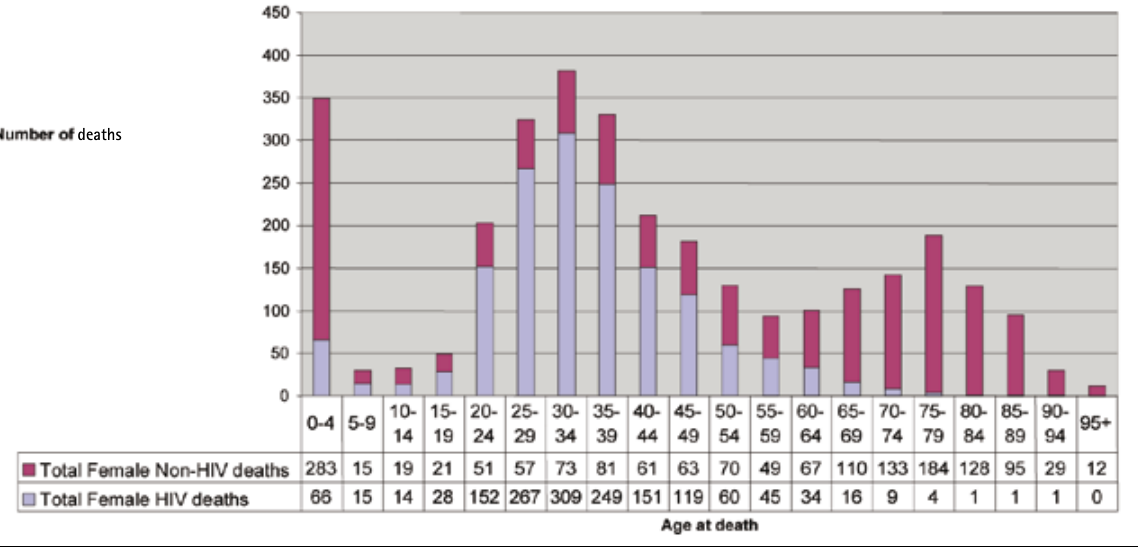
Fig. 2. Total female deaths 2003 - 2008 certified at Mosvold Hospital, Ingwavuma, northern KwaZulu-Natal, grouped according to HIV/AIDS-related and non-HIV/AIDS-related causes of death.